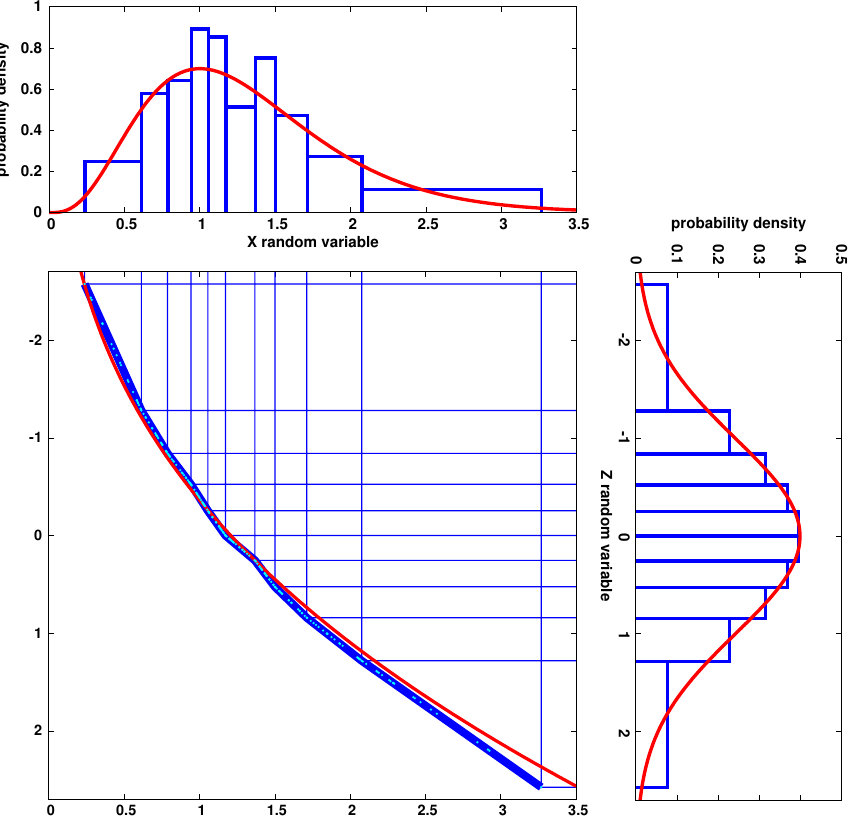
Fig. 1. Approximate piecewise linear Gaussian anamorphosis transformation (thick blue curve), remapping the deciles ˜ x k of a 200-member random sample of the Gamma distribution 0(k,θ) (top histogram) on the Gaussian deciles z k (right histogram), as compared to the exact transformation (in red) transforming the exact 0(k,θ) (red curve superposed to the top histogram) into N ( 0 , 1 ) (red curve superposed to the left